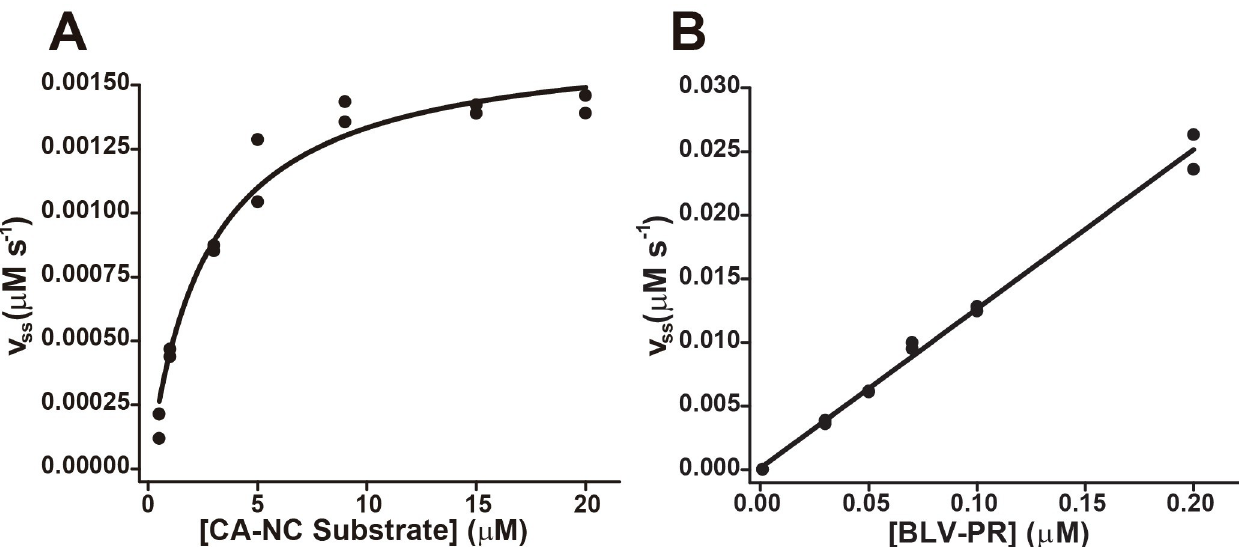
Fig 5. BLV-PR Kinetic parameters determined by using fluorogenic substrates. (A) Steady-state rate as a function of the CA-NC substrate concentration. BLV-PR (10 nM) was mixed with substrate CA-NC (0.05–20 μ M) in reaction buffer, at 37˚C, and the steady-state rate of hydrolysis was determined from the linear portion of the fluorescence increase. The black trace represents the best fit of the Michaelis-Menten equation. (B) Steady-state rate as a function of the enzyme concentration. CA-NC substrate (5 μ M) was mixed with BLV-PR (0.05–0.2 nM) in the same buffer. The black trace represents the best fit to a linear equation. The data points represent independent steady-state rate measurements for a representative experiment performed in duplicates. https://doi.org/10.1371/journal.pone.0271671.g005 of enzyme that is in the dimeric form and in the open conformation in the absence of the sub- strate. The different enzyme dilutions were incubated for 15 minutes at 25˚C to allow for dimer-monomer equilibration. Then, the reactions were started by adding the lowest possible MA-CA substrate concentration (1 μ M). The substrate concentration was chosen to be lower than K (2.1 ± 0.3 μ M for MA-CA) to minimize possible effects of the substrate on BLV-PR M dimerization. In this experimental design, the enzyme was diluted only 1.1-fold upon addition of substrate. As predicted, plots of initial rate as a function of total enzyme concentration (expressed as monomer) did not present a linear behavior. In contrast, the plots were qua- dratic, evidencing the equilibrium between the monomer and the BLV-PR dimer. From the fit of Eq 1 to the experimental data the value of the dimer-monomer equilibrium dissociation constant ( K ) was determined to be 160 ± 30 nM (Fig 6). DM